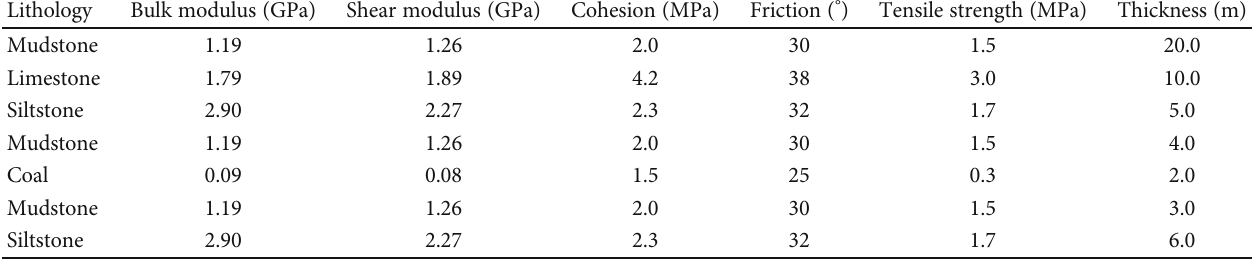
Table 1: The mechanical parameters of coal and